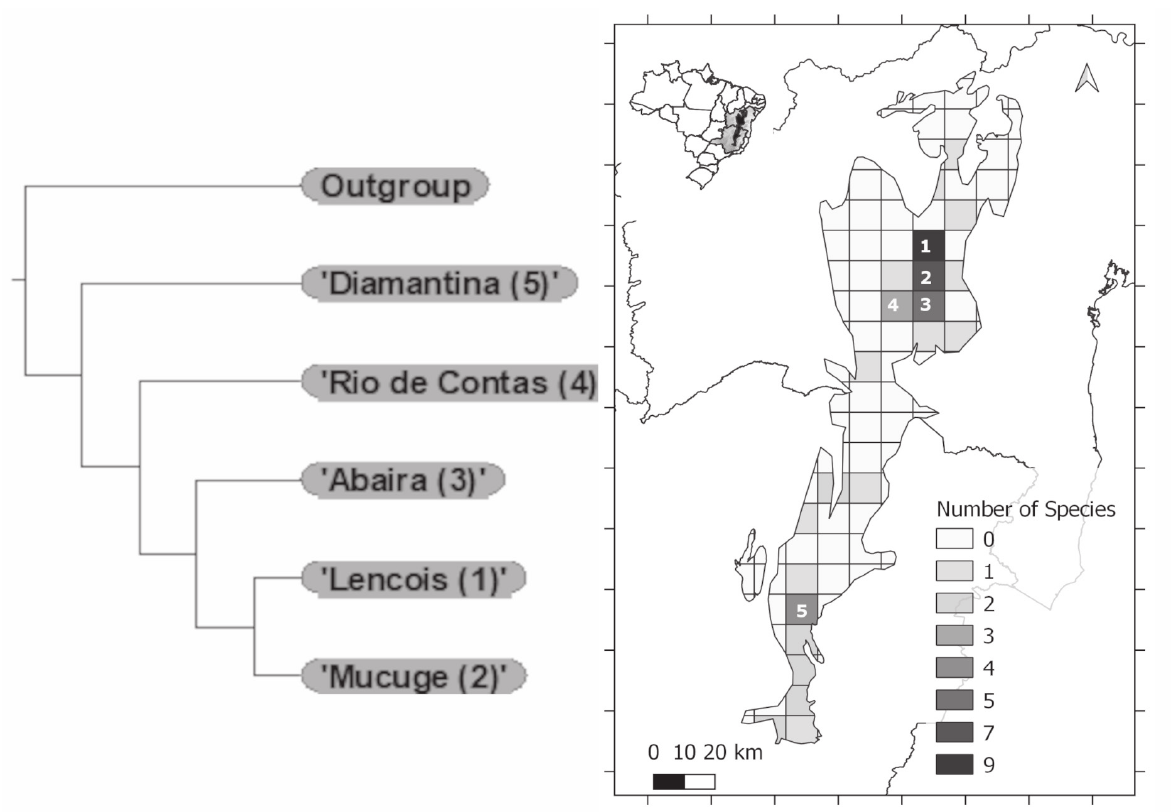
Figure 3. Parsimony Analysis of Endemism of Convolvulaceae species in the Espinhaço Range showing two main centers of endemism: one in Chapada Diamantina (grid cells 1 to 4) and another in Diamantina Plateau (grid cell 5). The numerical grid cells are partially equivalent to the territories of the municipalities of Lençóis, Mucugê, Abaíra, Rio de Contas (ERBA) and Diamantina